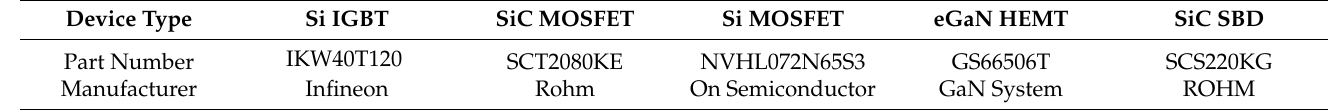
Table 2. Semiconductor devices selected for modelling and validation.